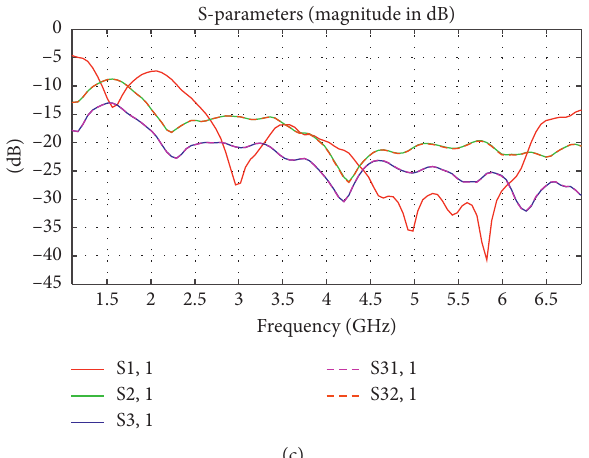
Figure 4: The horizontal scattering matrix of (a) 8 elements, (b) 16 elements: S1,1-S2,1-S3,1-S15,1-S16,1, and (c) 32 elements: S1,1-S2,1-